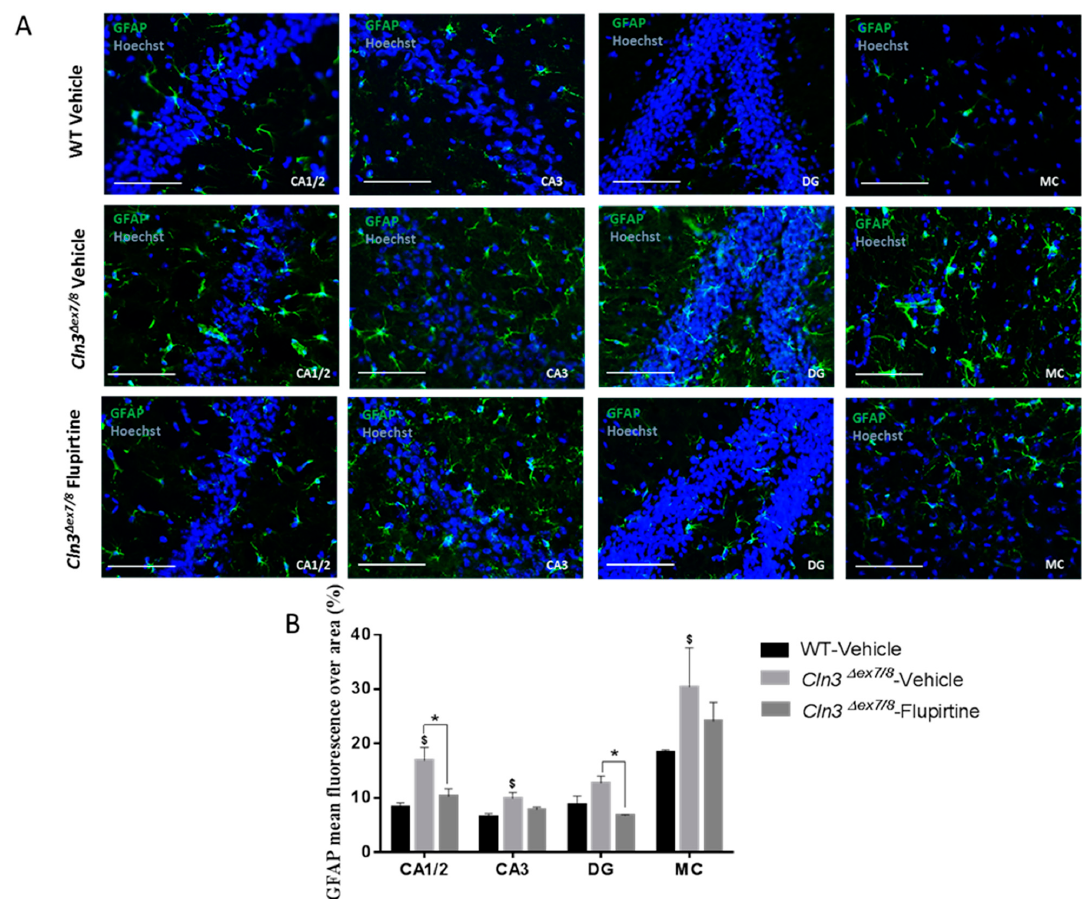
Figure 6. Impact of flupirtine supplementation on astrocytosis in hippocampus and motor cortex of male Cln3 ∆ ex7 / 8 mice. ( A ) Representative images of hippocampus regions CA1, CA2, CA3 and dentate gyrus (DG), as well as primary motor cortex from vehicle-treated WT, vehicle-treated Cln3 ∆ ex7 / 8 , and flupirtine-treated Cln3 ∆ ex7 / 8 male mice stained with GFAP in green and counterstained with Hoechst in blue ( n = 4; Scale bars = 20 μ m).; ( B ) Glial fibrillary acidic protein (GFAP) mean fluorescence over area in vehicle-treated WT, vehicle-treated Cln3 ∆ ex7 / 8 , and flupirtine-treated Cln3 ∆ ex7 / 8 male mice in hippocampus regions CA1, CA2, CA3 and dentate gyrus (DG), as well as in primary motor cortex (MC). Data are expressed as mean ± SEM. $ p < 0.05 compared to vehicle-treated WT, * p < 0.05 compared to vehicle-treated Cln3 Δ ex7/8 .